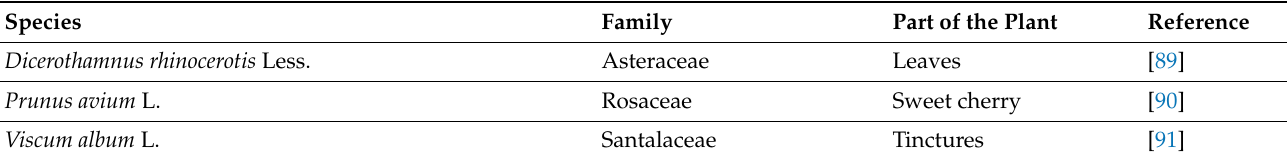
Table 2. Cont. Species Family Part of the Plant Reference Dicerothamnus rhinocerotis Less. Asteraceae Leaves [89] Prunus avium L. Rosaceae Sweet cherry [90] Viscum album L. Santalaceae